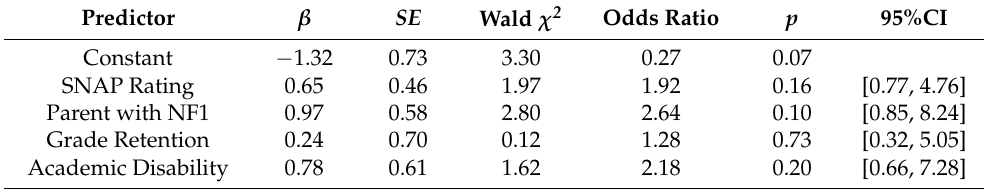
Table 7. Logistic regression analysis of concordant parent/child reports of bully